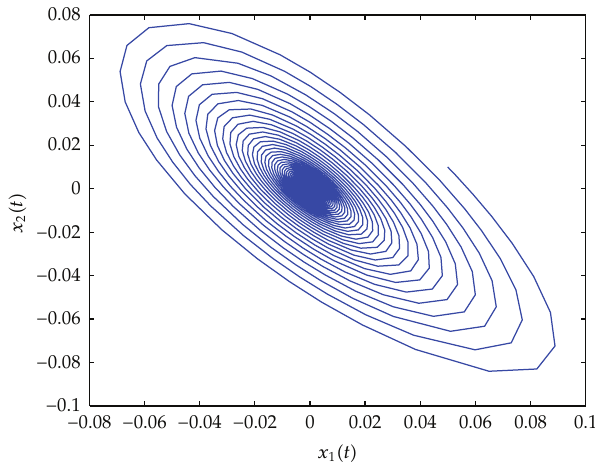
Figure 3: Trajectories graphs of the system (cid:2) 4.1 (cid:3) with τ 1 (cid:6) 0 . 003 ,τ 2 (cid:6) 0 . 004, and τ 1 (cid:7) τ 2 (cid:6) 0 . 007 < τ 0 ≈ 0 . 01. The equilibrium E ∗ (cid:2) 0 , 0 (cid:3) is asymptotically stable. The initial value is (cid:2) 0.05, 0.01 (cid:3) .